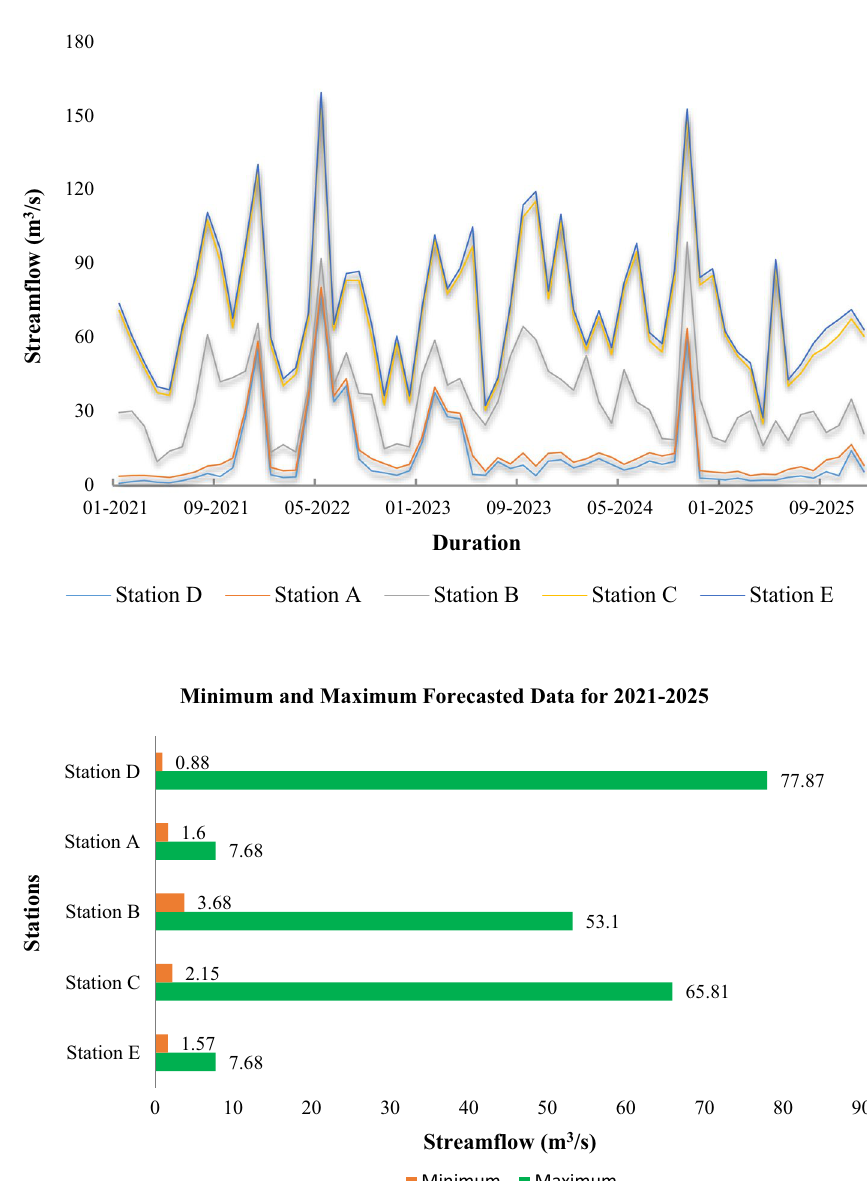
Fig. 6 Forecasted streamflow